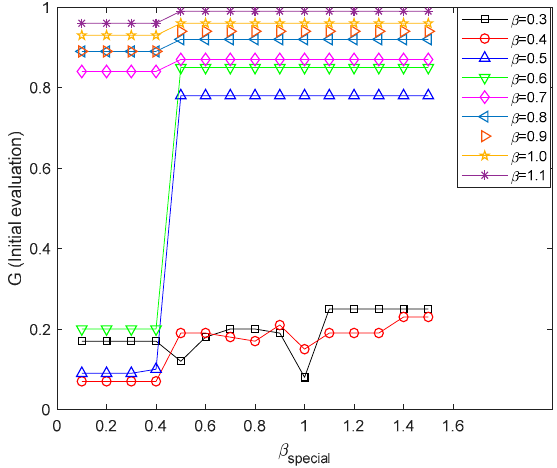
Figure 6. The influence of single-hop cluster head node capacity on M.